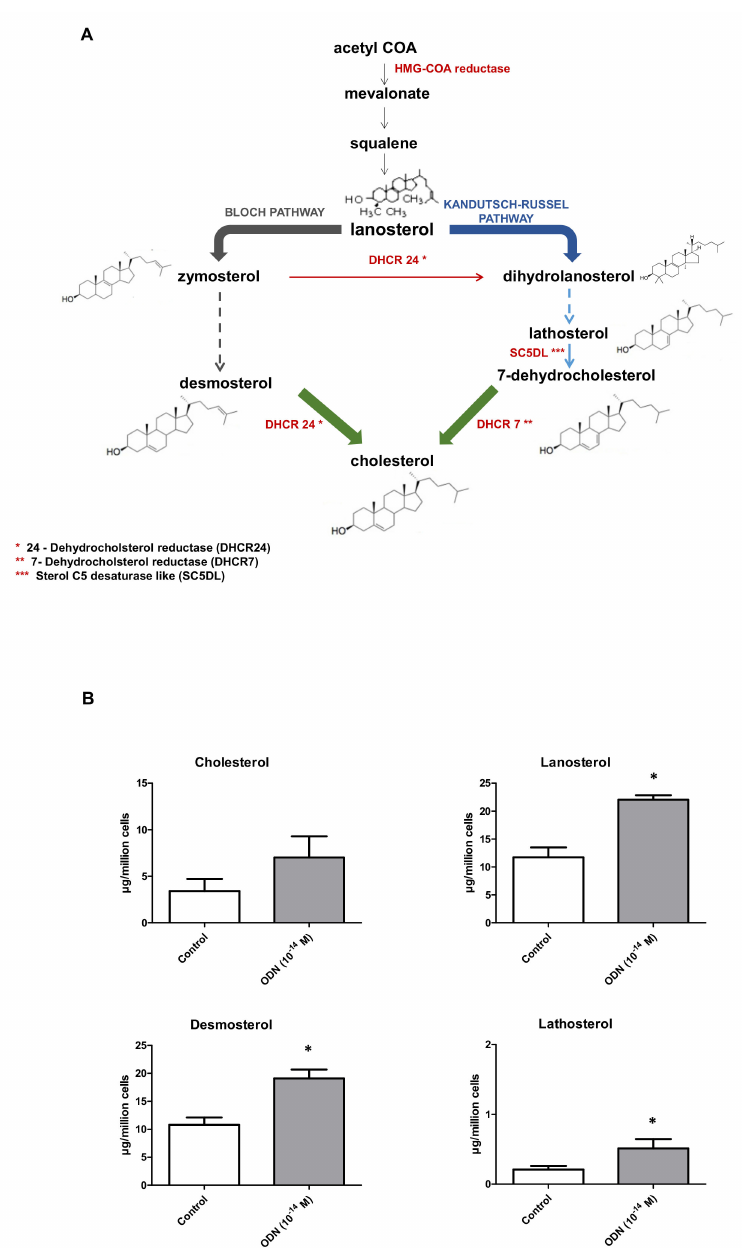
Figure 7. E ff ect of ODN on cholesterol and cholesterol precursor profiles in N2a cells. Lanosterol, the final product of the mevalonate pathway, desmosterol (specific of the Bloch pathway), and lathosterol (specificoftheKandutsch-Russelpathway)arethreeprecursorsofcholesterol( A ).Cholesterol, lanosterol, desmosterol, and lathosterol were quantified by GC / MS in untreated and ODN (10 − 14 M) – treated